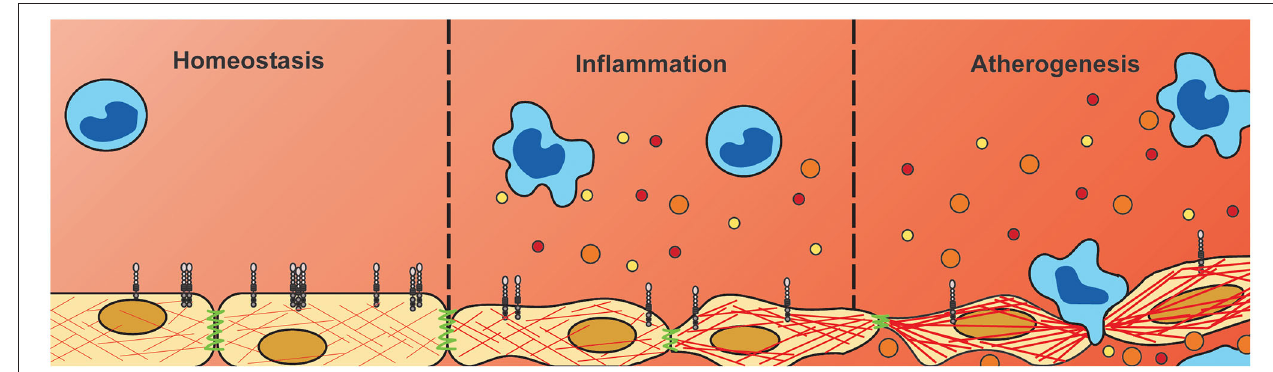
FIGURE 7 | Downregulation of endothelial PLXNA4 under inflammatory conditions diminishes vascular integrity. Current hypothesis of the role of PLXNA4 in vascular integrity. Under homeostatic conditions PLXNA4 is expressed in endothelial cells resulting in a stable endothelial barrier. Inflammatory conditions reduce PLXNA4 expression resulting in rearranged cytoskeletal structures and cell-cell junctions. In turn this leads to decreased endothelial barrier function, impaired tube formation and increased vascular permeability to solutes and cells. This decrease in vascular integrity could contribute to atherogenesis by increasing deposition of (inflammatory) cells and lipids into the arterial